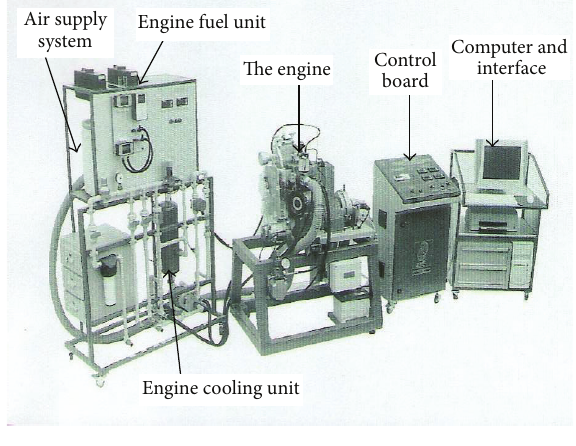
Figure 1: Test rig [14].